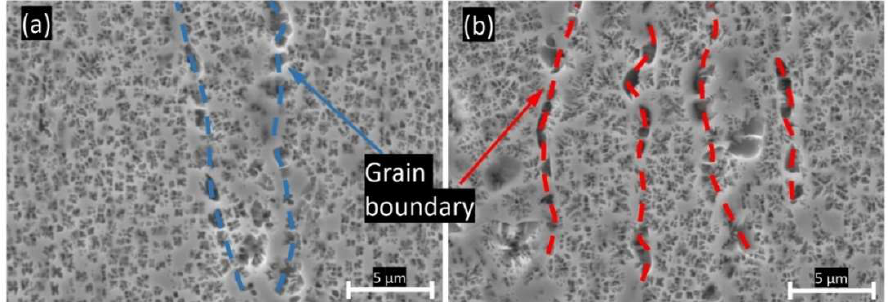
Figure 7. SEM micrograph of ( a ) E1 sample before test; ( b ) E2 sample before test.